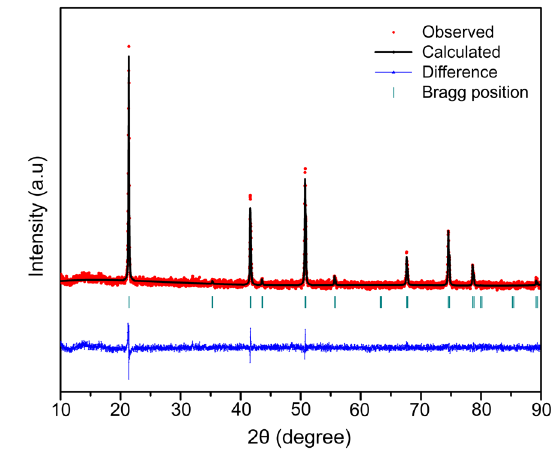
Fig. 1. X-ray diffraction patterns of Li